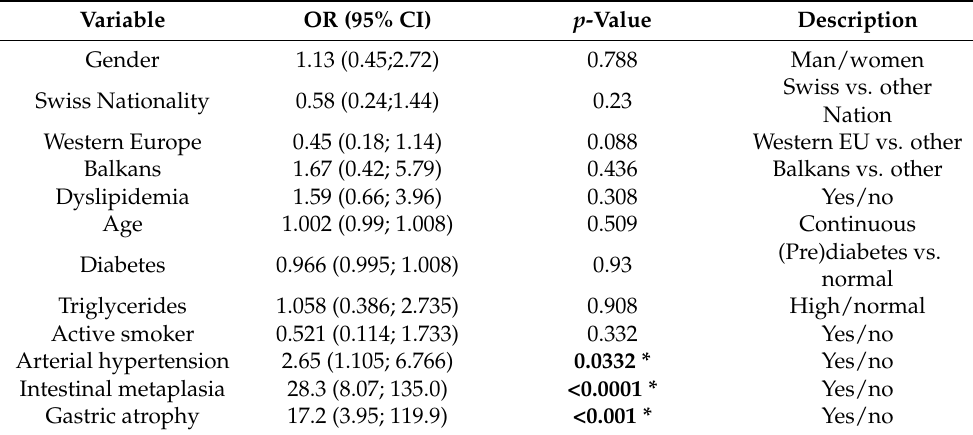
Table 2. Comparison of different variables between Helicobacter pylori positive and negative groups.